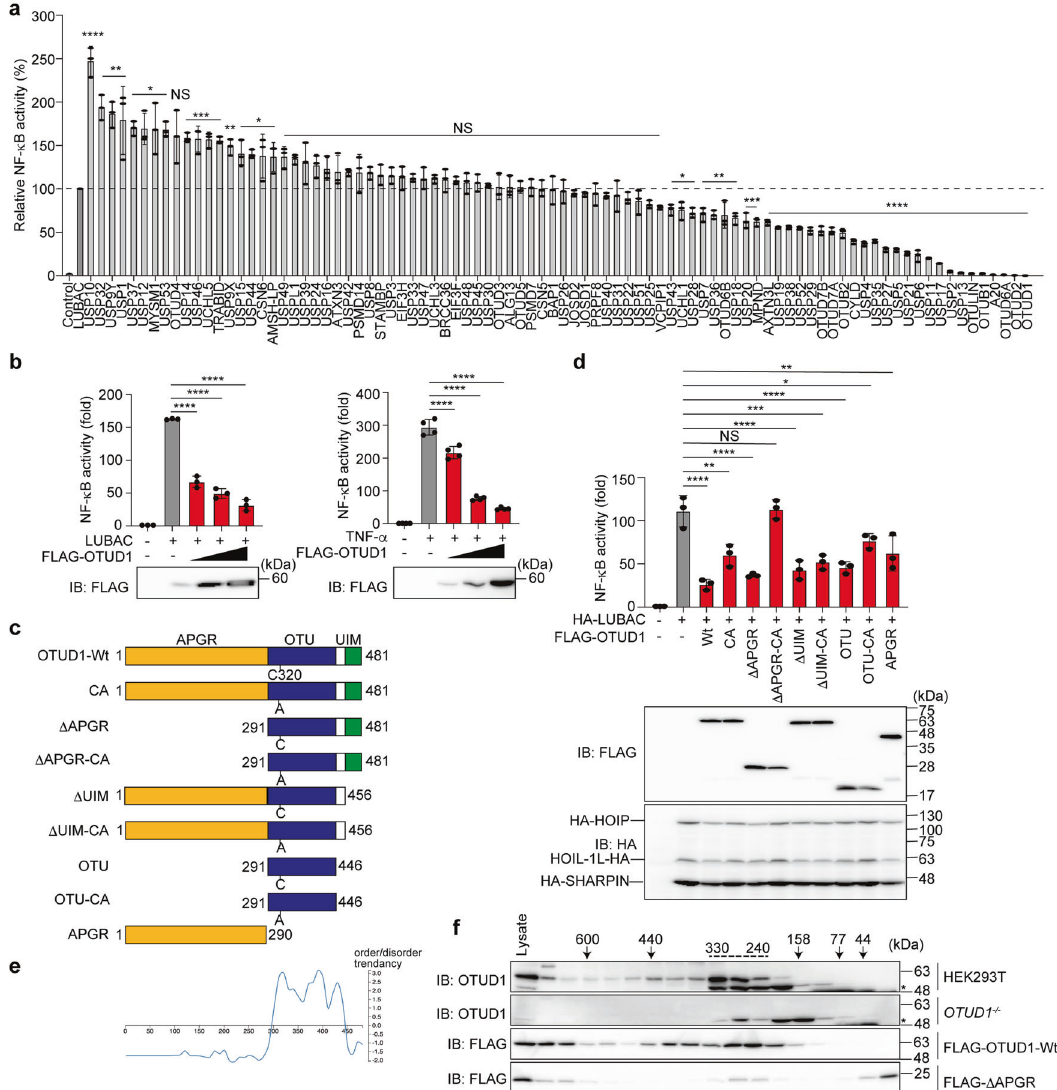
Fig. 1 OTUD1 suppresses canonical NF- κ B activation through the catalytic activity and the N-terminal region. a Screening for DUBs that regulate LUBAC-mediated NF- κ B activation. Effects of 88 human DUBs on LUBAC-induced NF- κ B activation were analyzed by a luciferase assay. b Dose-dependent inhibition by OTUD1 on LUBAC- and TNF- α -induced NF- κ B activation. Effects of increasing amounts (0.1, 0.3, and 1.0 μ g) of OTUD1 were examined with co-expression of LUBAC or 6 h treatment with 10 ng/ml TNF- α in HEK293T cells. c Domain structure of wild-type (Wt) and mutants of OTUD1. APGR: Ala-, Pro-, and Gly-rich region; OTU ovarian tumor protease, UIM ubiquitin-interacting motif. d Effect of OTUD1 mutants on the LUBAC-induced NF- κ B activity. The relative NF- κ B activity induced in the presence of Wt or various mutants of OTUD1, and expression levels of OTUD1 and LUBAC subunits are shown. a , b , d Data are shown as mean ± SD by ANOVA post-hoc Tukey test ( n = 3 or 4). * P < 0.05, ** P < 0.01, *** P < 0.001, **** P < 0.0001, NS not signi fi cant. e The N-terminal APGR region is disordered. Intrinsically ordered and disordered segments of OTUD1 were analyzed by DICHOT [12] (https://idp1.force.cs.is.nagoya-u.ac.jp/dichot/). f OTUD1 eluted in the high molecular weight fractions. Gel fi ltration analyses of lysates prepared from parental and OTUD1 − / − cells, and FLAG-OTUD1-Wt- and FLAG- Δ APGR-expressing HEK293T cells were performed using a Superdex 200 column. Concentrated fractions were subjected to immunoblotting with the indicated antibodies. *Non-speci fi c (Fig. 1a). Taking the NF- κ B activity induced by the expression of LUBAC alone as 100%, its co-expression with 16 DUBs, such as USP10, upregulated the NF- κ B activity. In contrast, 34 DUBs signi fi cantly downregulated the LUBAC-induced NF- κ B activation.